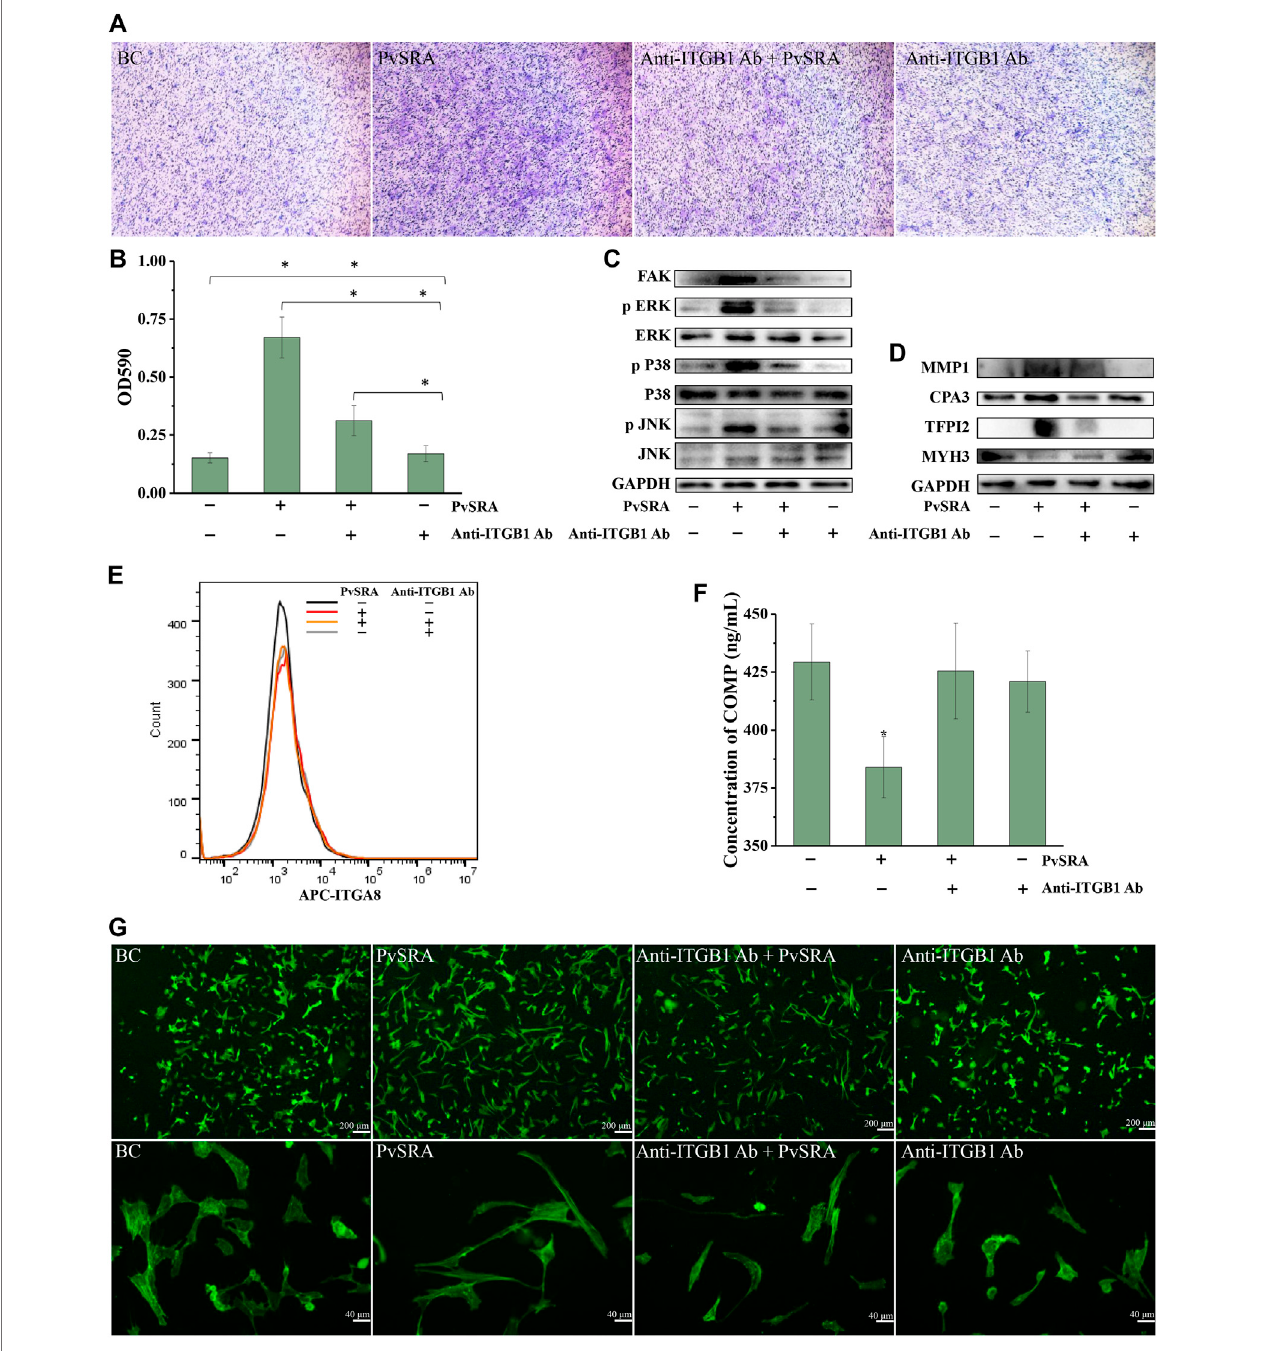
FIGURE 6 | PvSRA attracted migration of HSF and participated in the changing of focal adhesion, extracellular matrix, and actin cytoskeleton of HSF through PvSRA – ITGB1 axis. (A) Transwell method was applied to test the effect of PvSRA on HSF migration in vitro . (B) Quanti fi cation assay of the effect of PvSRA on HSF migration by absorptiometry. Asterisk (*) represents that it has statistic difference between groups. (C) WB analysis of the expression of FAK and MAPK of PvSRA- treated HSF. (D) WB analysis of protein expression of the representative DEGs that were involved in extracellular matrix, focal adhesion, and actin cytoskeleton of PvSRA-treatedHSF. (E) ExpressionofITGA8onHSFcellsurfacewastestedbyFACS. (F) COMPsecretionwastestedbyElisamethod.Asterisk(*)representsthatithas statistic difference with other groups in same phase. (G) The effect of PvSRA on HSF cell cytoskeleton was observed by using FITC phalloidin.